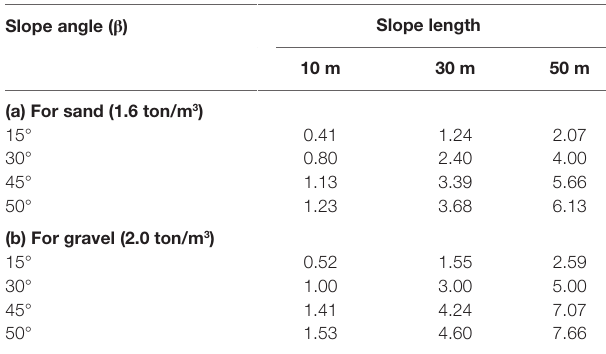
TaBle 6 | Minimum required strength (kg/cm 2 ) as a function of length and angle of the slope for sand and